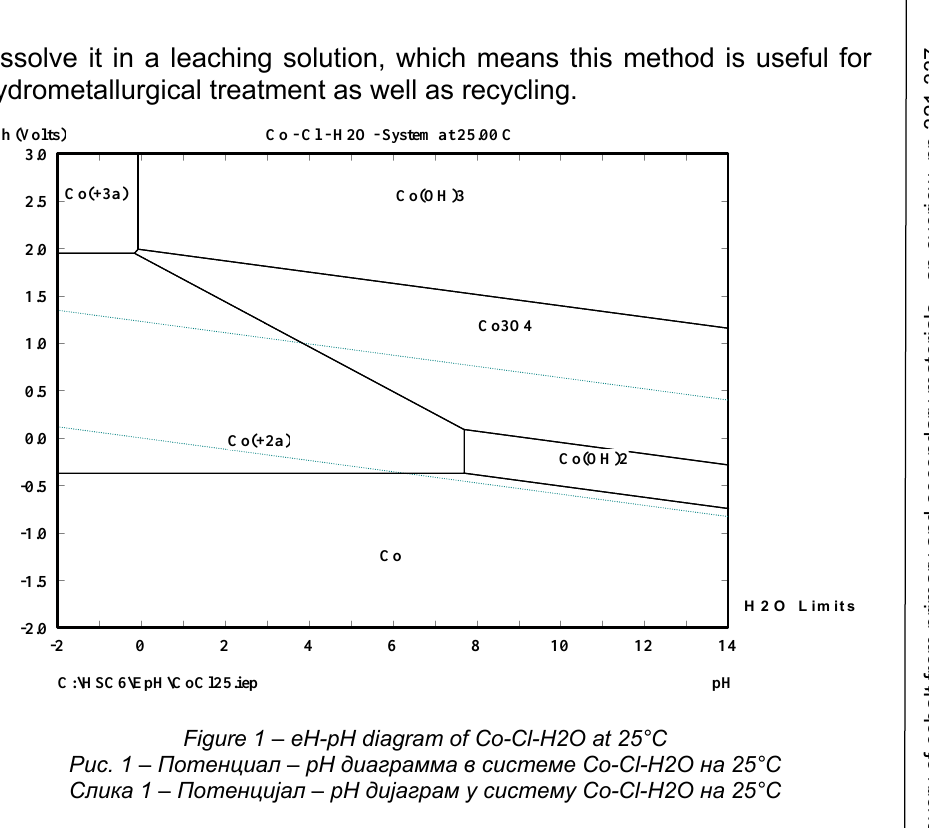
Figure 1 – eH-pH diagram of Co-Cl-H2O at 25°C Рис . 1 – Потенциал – pH диаграмма в системе Co-Cl-H2O н a 25°C Слика 1 – Потенцијал ‒ pH дијаграм у систему Co-Cl-H2O н a